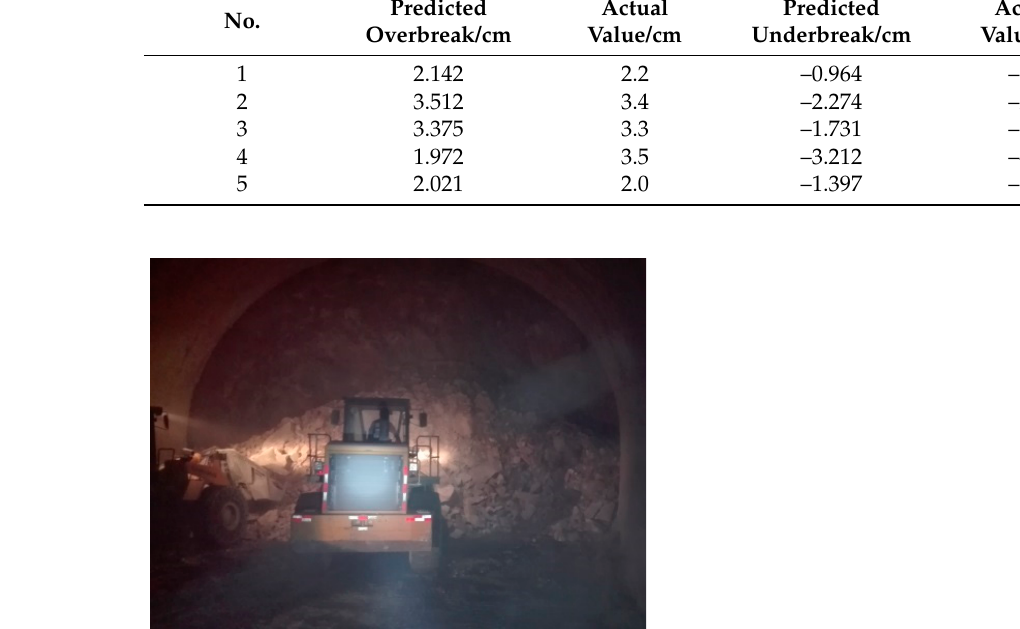
Table 8. Comparison between predicted values and actual values.